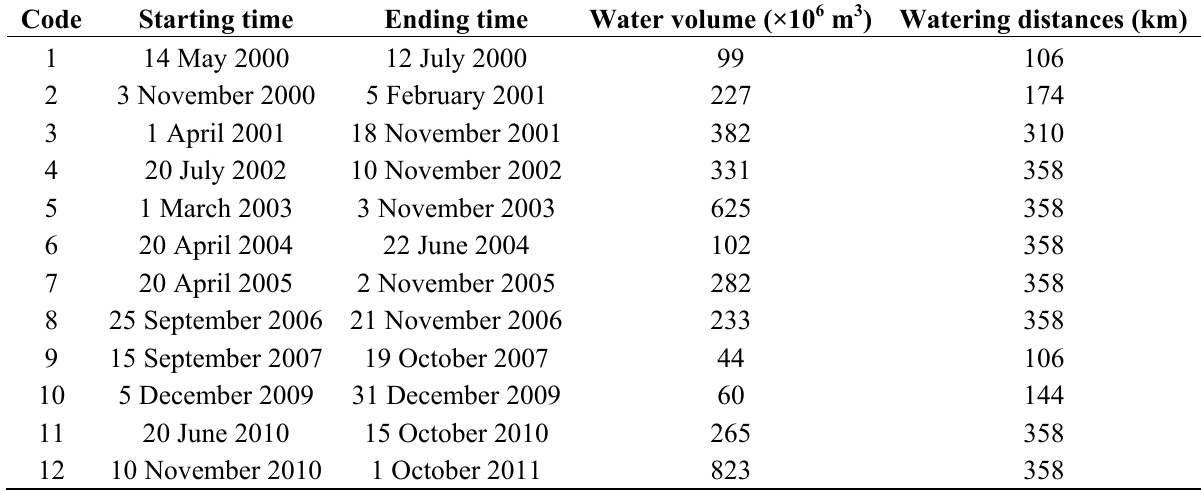
Table 1. Statistics for the 12 intermittent water deliveries to the lower Tarim River, in which the watering distances represent the longest distance along the river channel that the water